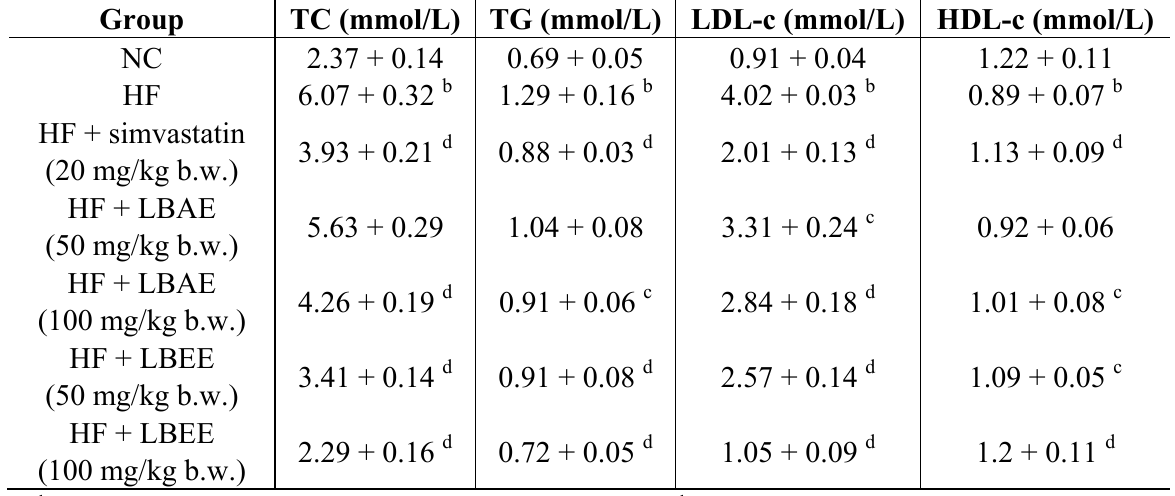
Table 2. Effect of LBAE and LBEE on serum TC, TG, LDL-C, HDL-C levels in